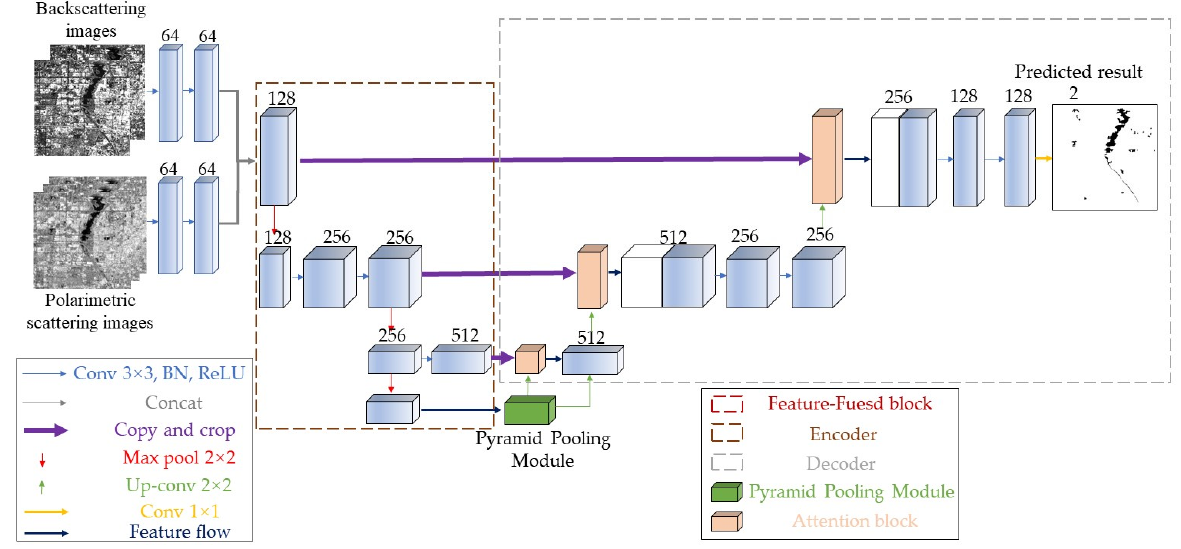
Figure 5. Structure of FFEDN.